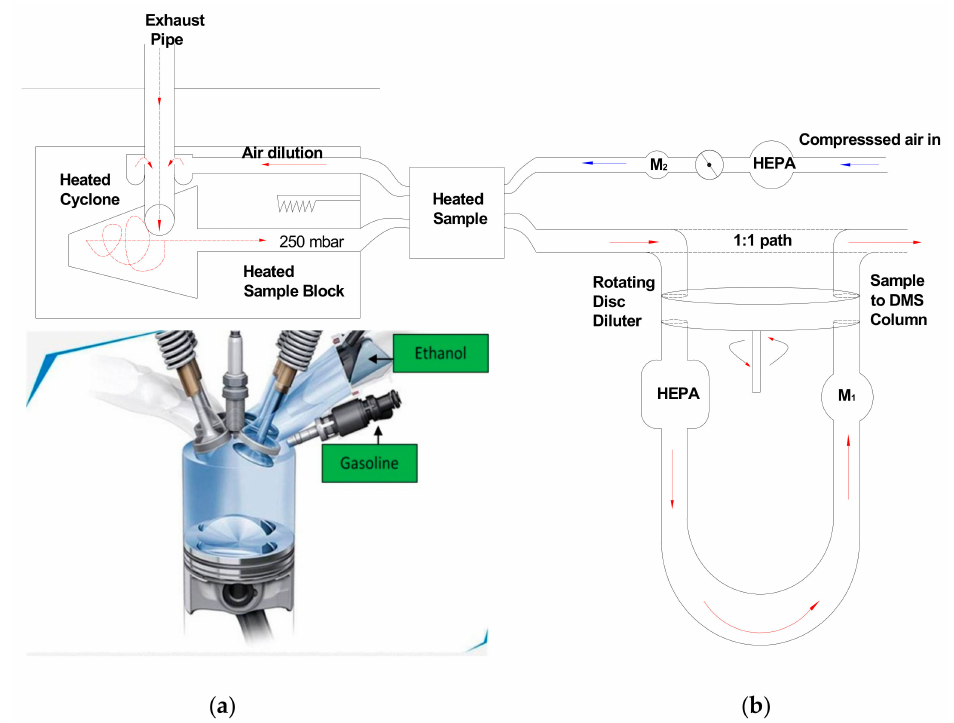
Figure 2. ( a ) Combined injection structure; ( b ) Particle sampling dilution